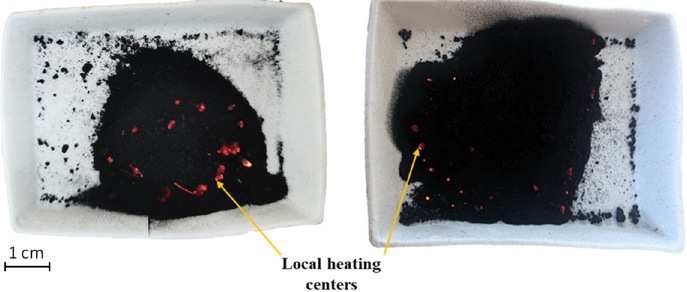
Figure 17. Samples directly after microwave treatment.